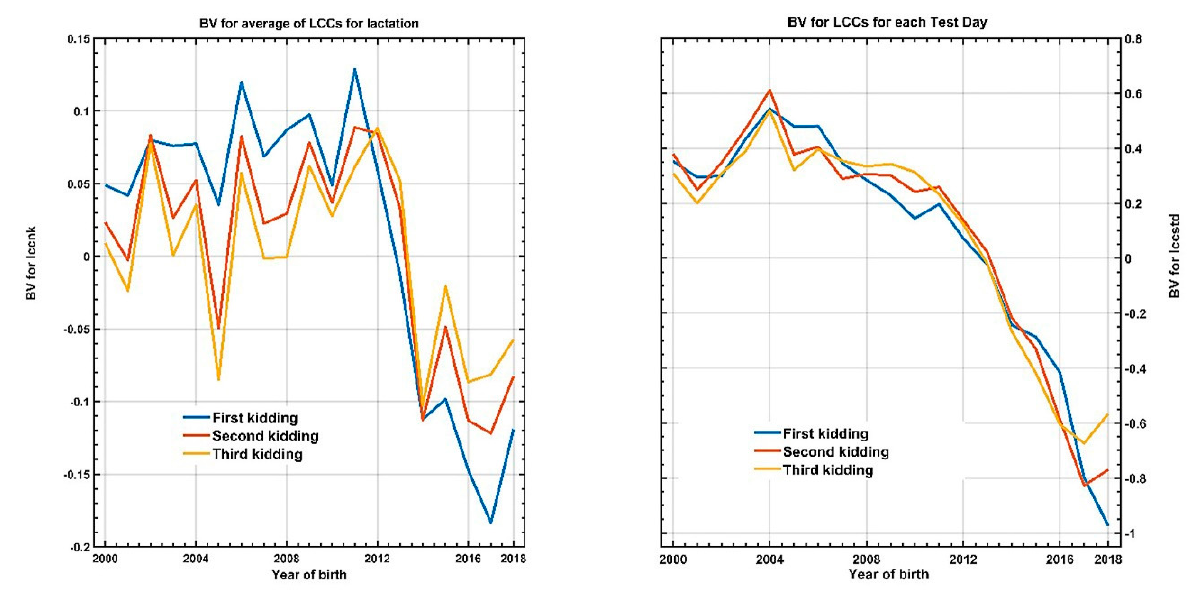
Figure 7. Observed evolution of EBV for both expressions levels of somatic cell count in each parity, as a function of the goats’ year of birth. Table 5. Results of principal component analysis, the conformation of index (Ipc) and correlations between Ipc and original breeding values for each